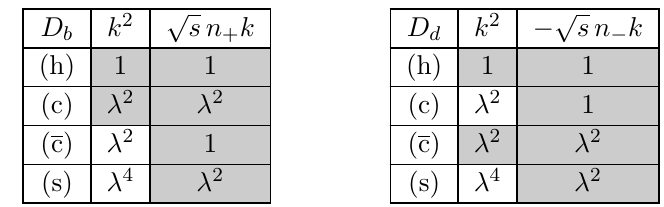
Table 1 . Scaling associated with the terms in the propagators D b and D d , as de(cid:12)ned in eq. (2.17), where we set s (cid:24) 1. Leading terms in each region are highlighted in